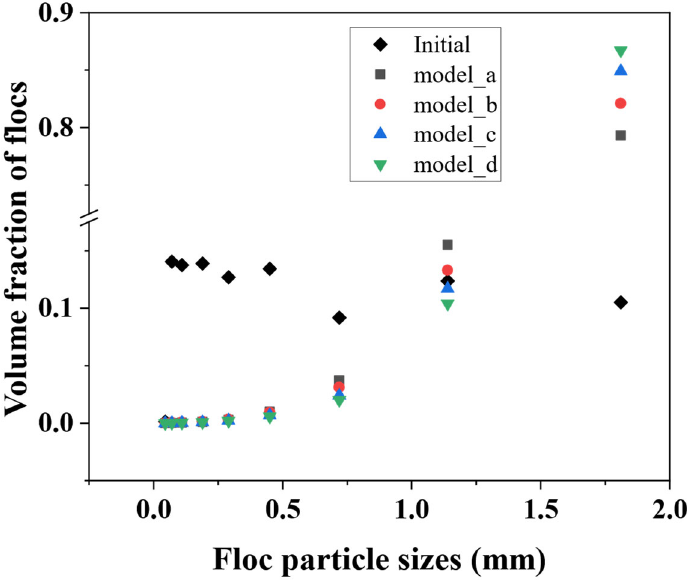
Figure 16. Variation in volume fraction of flocs at each scale in the external flow field for different types of conical deflectors.